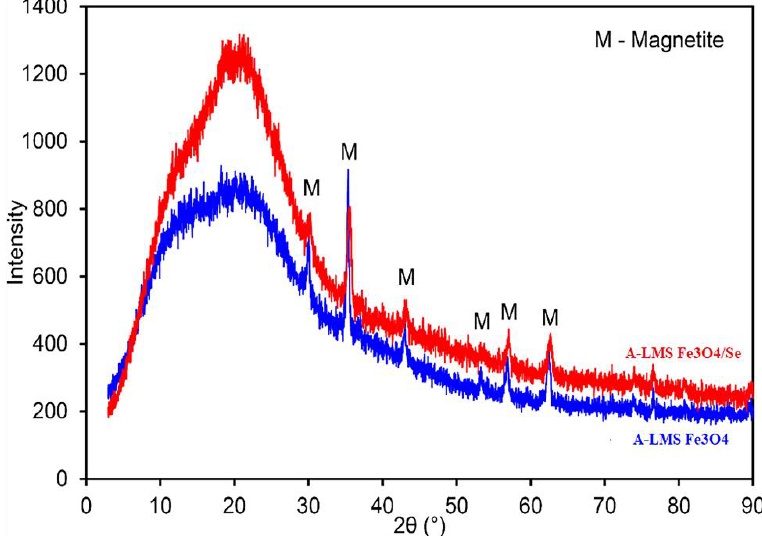
Figure 7. XRD analysis of the A-LMS Fe 3 O 4 (blue) and A-LMS Fe 3 O 4 /Se (red) adsorbent.